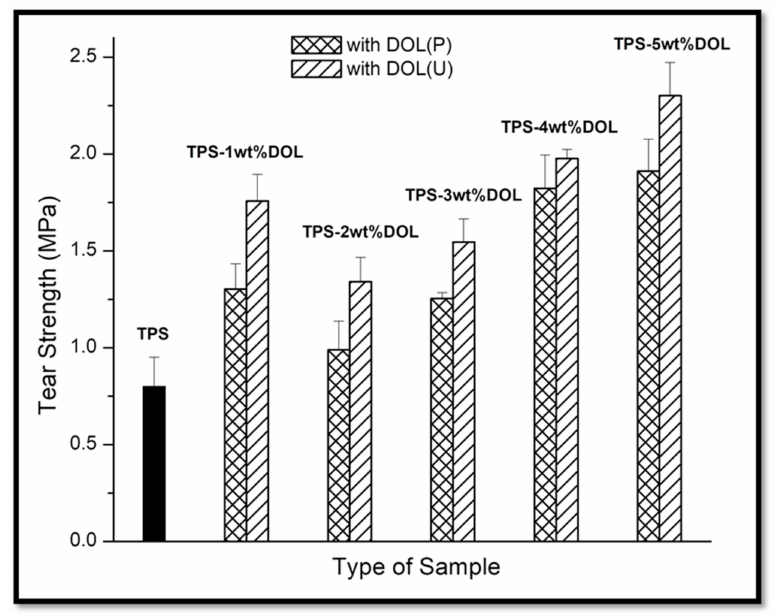
Figure 13. Tear strength of TPS film and TPS-DOL biocomposite